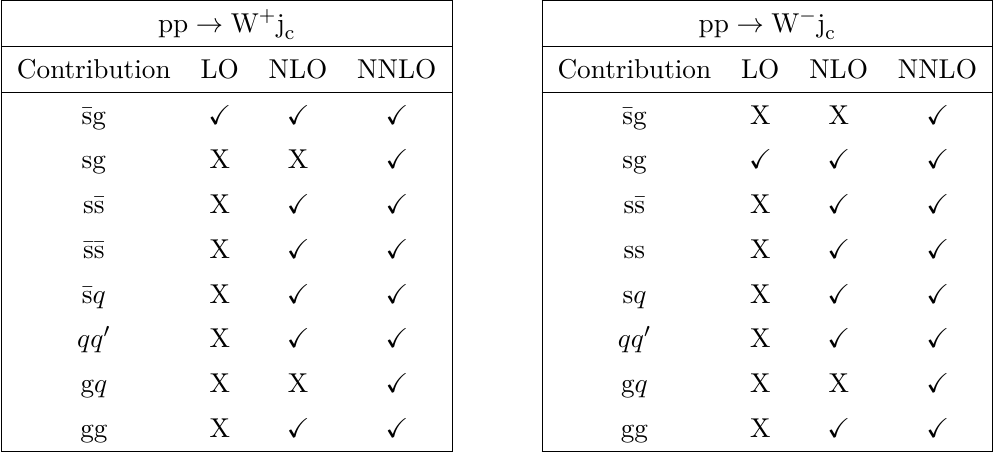
and pp → W − j that are present at c c